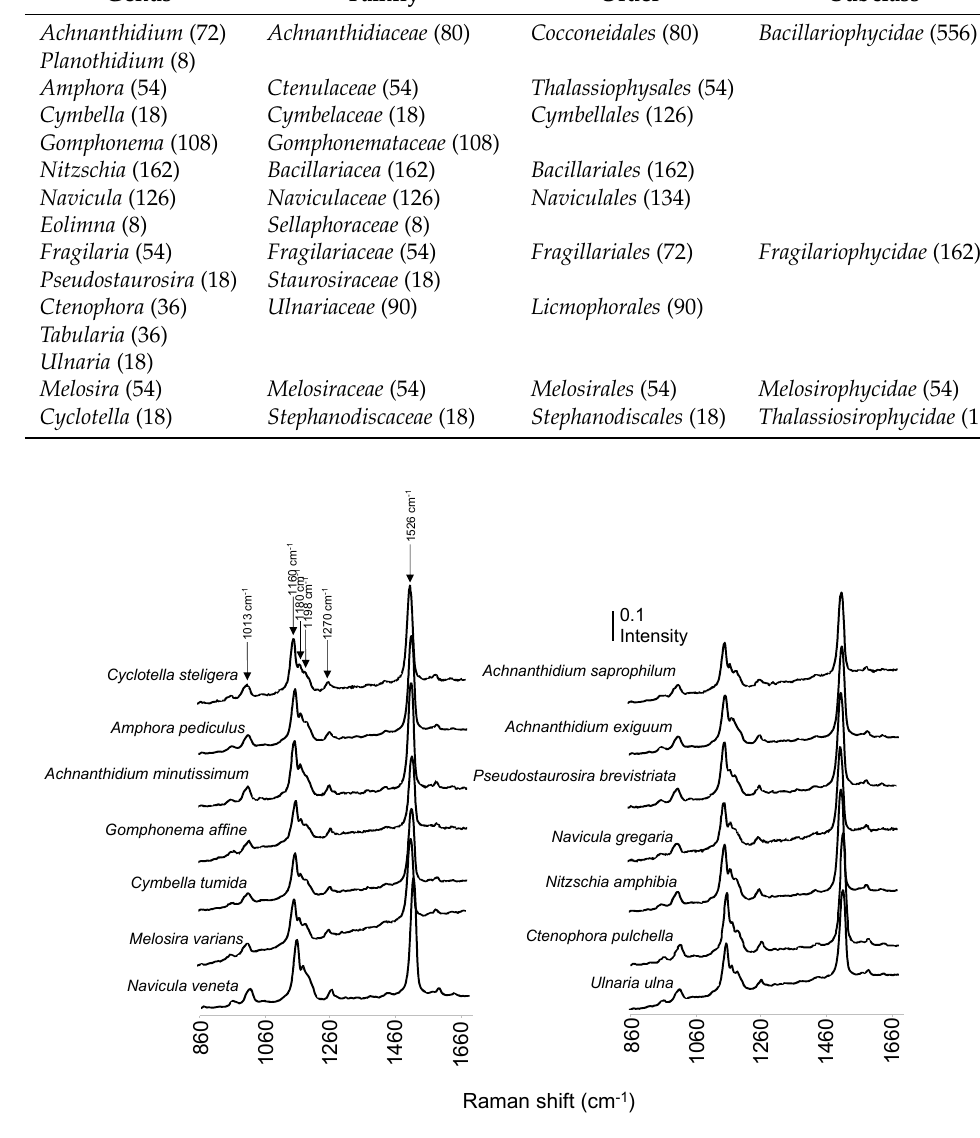
Figure 2. Raman spectra recorded in the 860 to 1660 cm − 1 spectral range from different diatom species. The most important bands identified by the partial least squares discriminant analysis are marked with arrows: 1013 cm − 1 ; 1160 cm − 1 ; 1180 cm − 1 ; 1198 cm − 1 ; 1270 cm − 1 ; 1526 cm − 1 . A PLS-DA regression was done with the data obtained for the species showing >1% For result interpretation purposes, the scalar projections were calculated (see the abundance to depict their Raman profiles. Six significant components were identified by methods section). These provided an integrated measure of the relationship the PLS-DA. Eleven variables were found to have important contribution to these compo- nents (Figure S1, Support Information), which were associated to six different bands: width (W) of the bands at 1526, 1160, 1013, and 1198 cm − 1 , area (A) of the band at 1160 cm − 1 and frequency (F) of the bands at 1526, 1270, 1013, 1180, 1160, and 1198 cm − 1 . From the